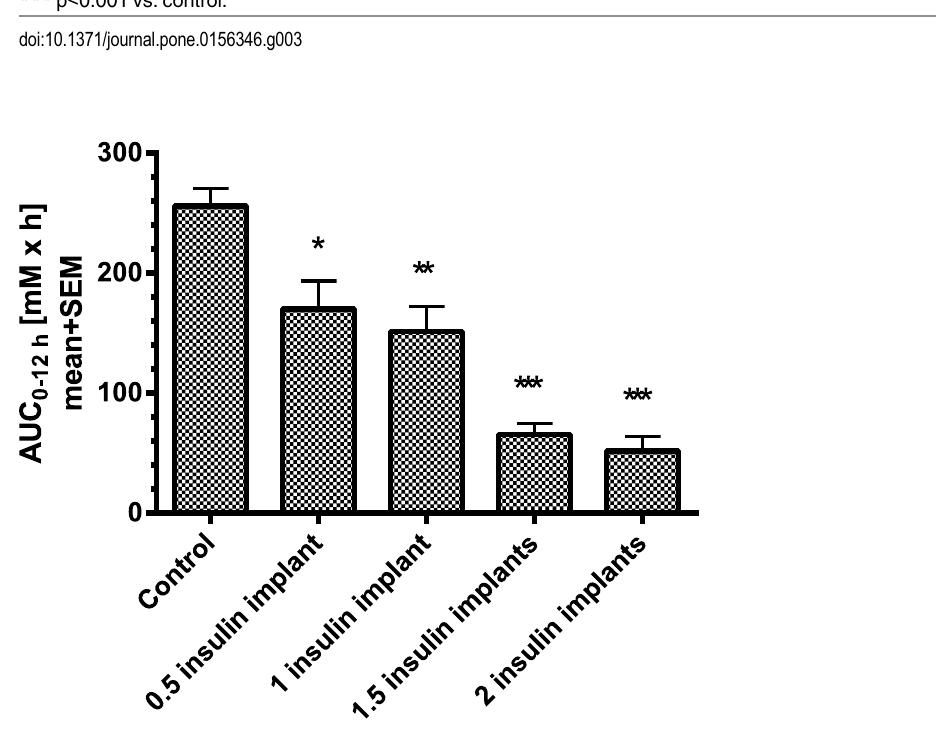
Fig 4. The calculated 12 h-blood glucose AUC (AUC 0-12h ) of STZ-rats (n = 5 per group). * p < 0.05, ** p < 0.01, *** p < 0.001 vs. control.